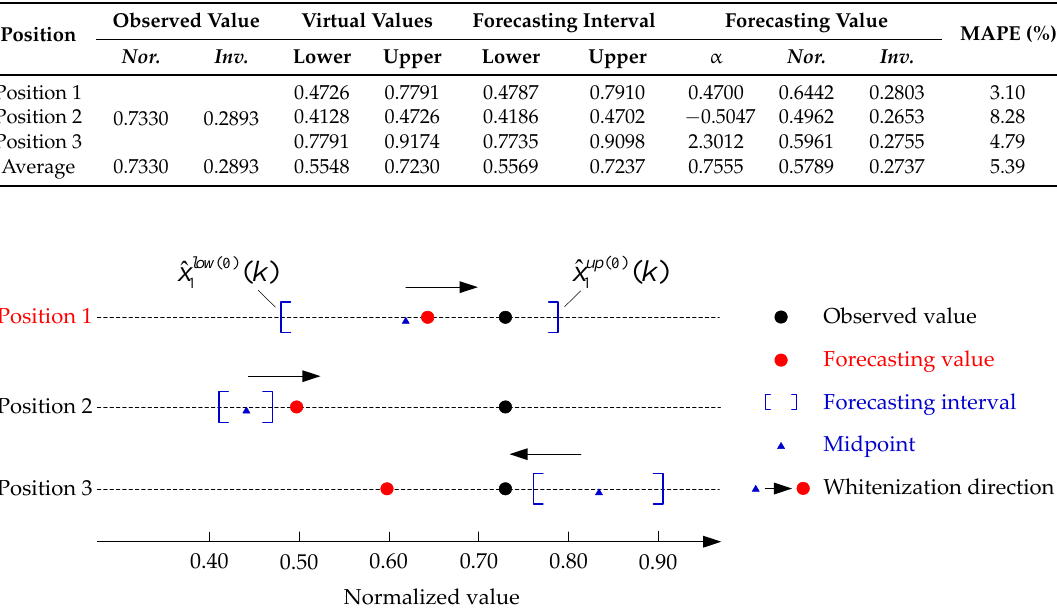
Table 6. Forecasting results of April 2016 in Positions 1–3.